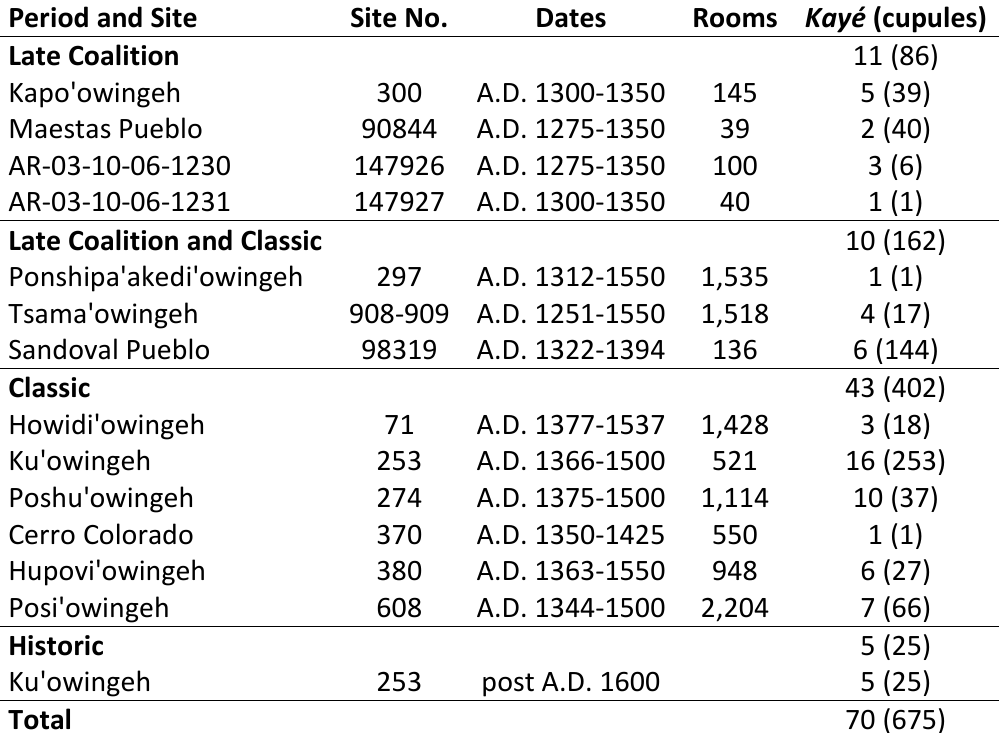
Table 1. Sites from the Rio Chama watershed analyzed for this